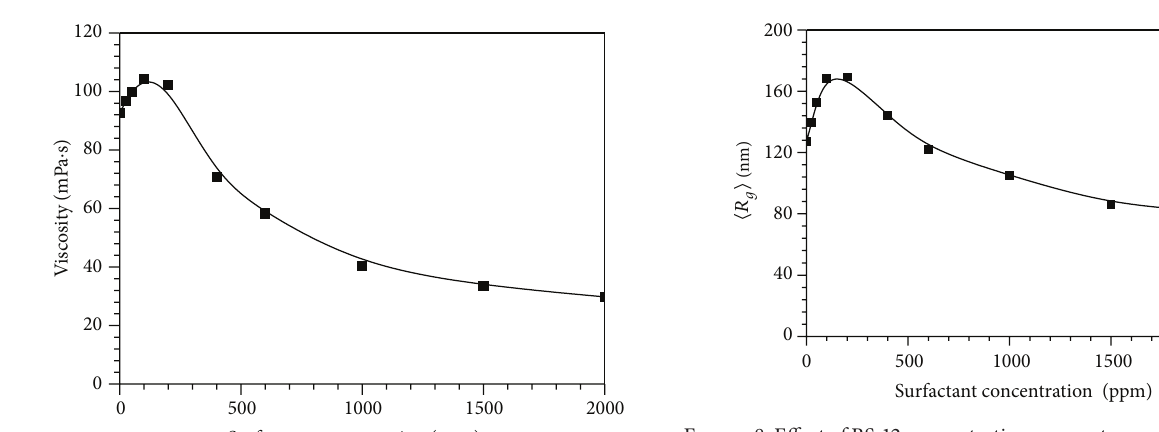
Figure 8: Effect of BS-12 concentrations on root mean square radius of gyration ( ⟨𝑅 𝑔 ⟩ ) of HAPAM.